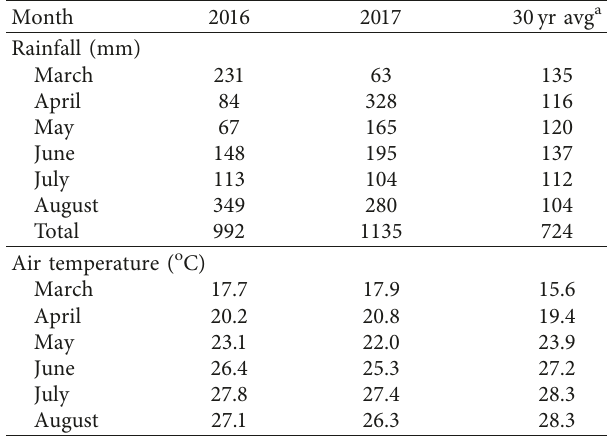
Table 1: Average monthly rainfall and air temperatures during the growing season in 2016 and 2017 compared with the 30-year average.